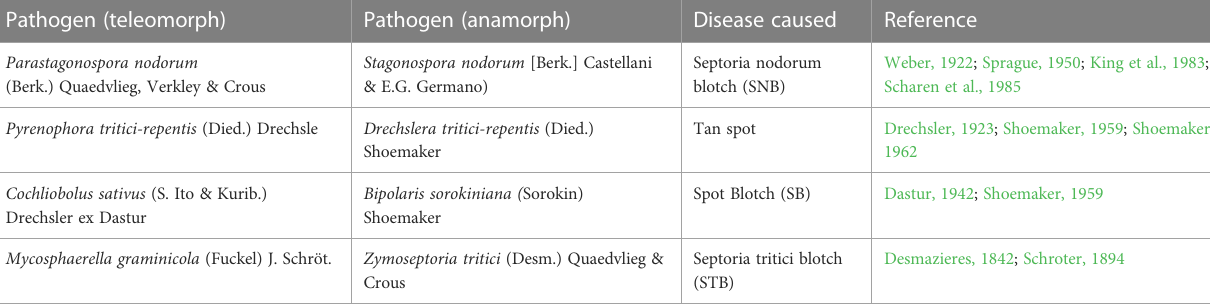
TABLE 2 Necrotrophs and hemibiotrophs causing diseases in